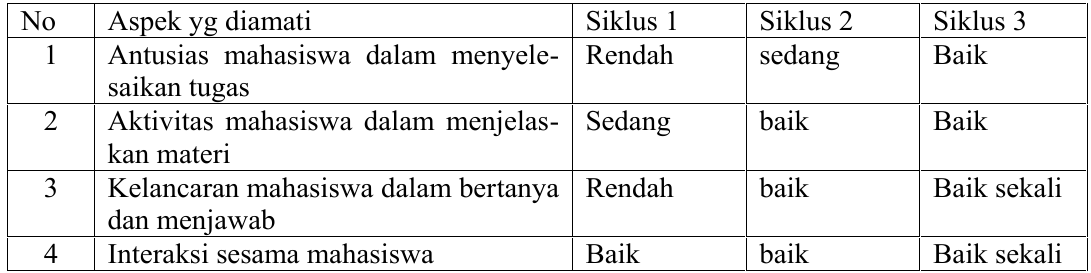
Tabel 3. Hasil Pengamatan Kegiatan Mahasiswa pada saat proses Pembelajaran No Aspek yg